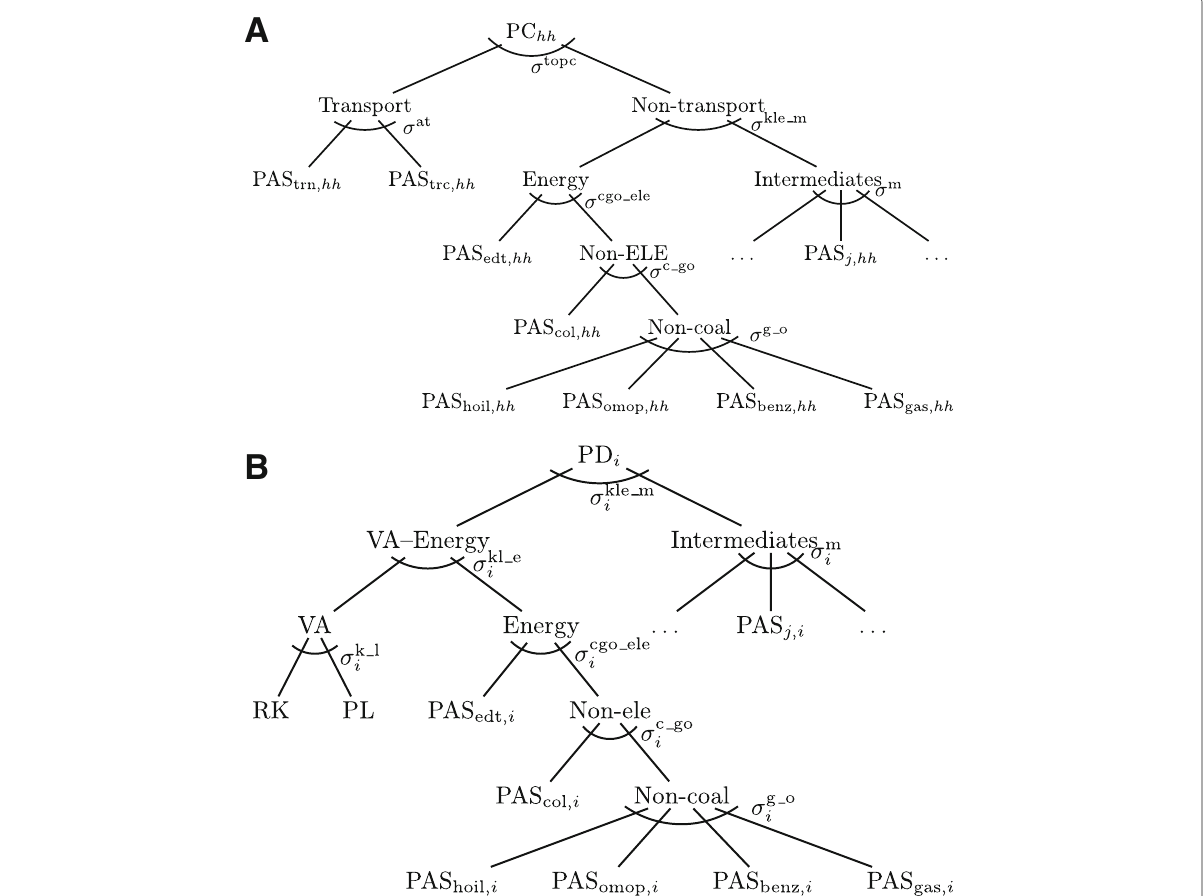
Fig. 8 Nesting of constant-elasticity-of-substitution (CES) functions in production and consumption. Notes: Intermediate demand by sector i of good j is bought on Swiss markets at prices PAS j , i . The costs for labor and capital are reflected by PL and PK . Sectoral output is prices PD i . PAS i , hh are the prices of commodities i purchased on national markets by households. a Consumption. b